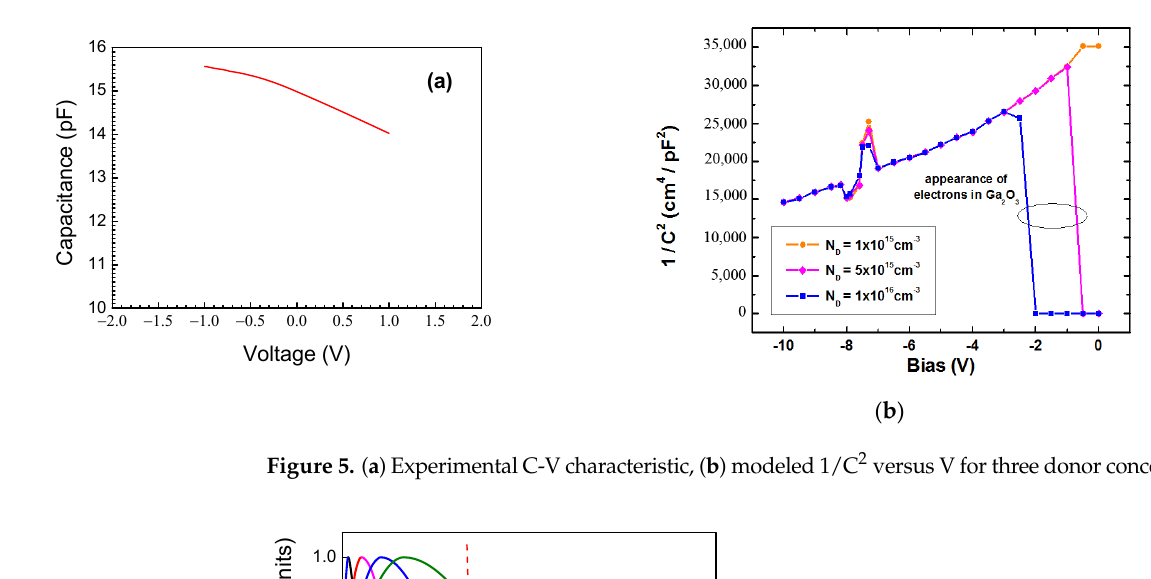
Figure 4. Room temperature C ‐ f characteristic of the sample.